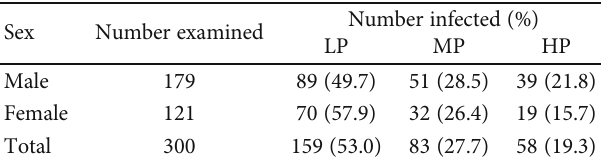
Table 2: Relationship between symptoms and sex among study participants.